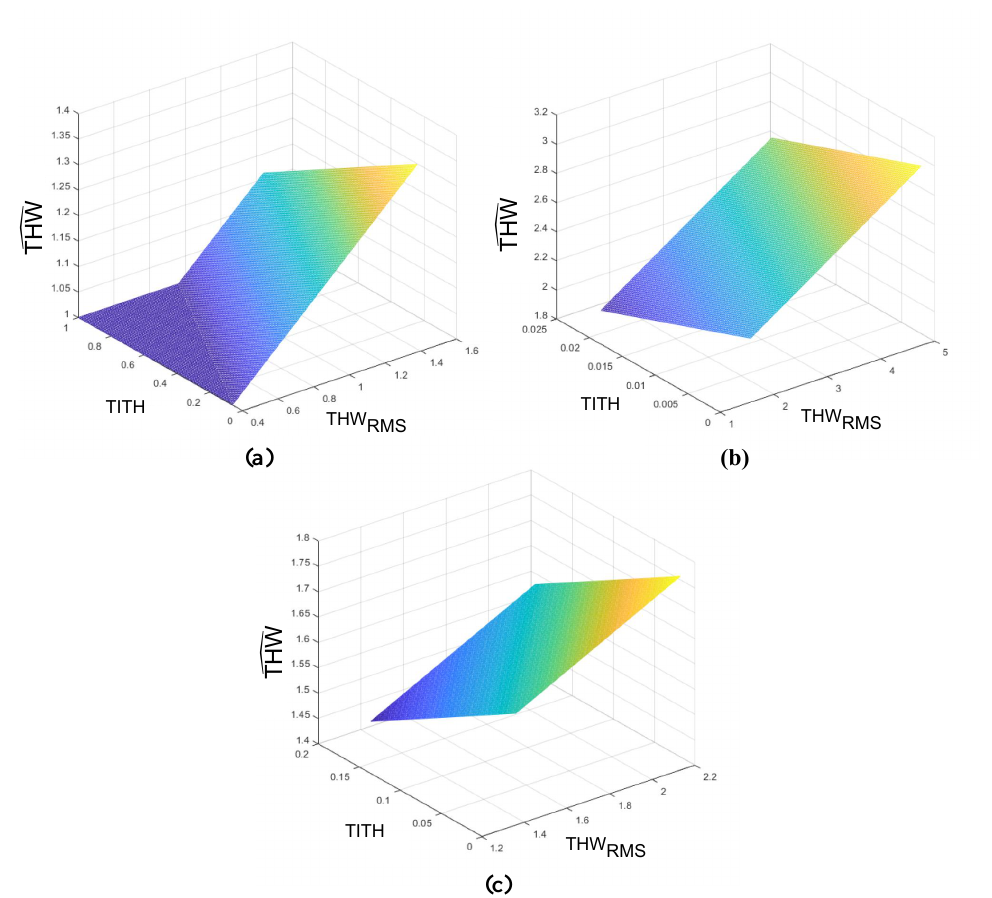
Figure 13. (cid:100) THW i model planes for ( a ) Cluster 1, ( b ) Cluster 2, and ( c ) Cluster